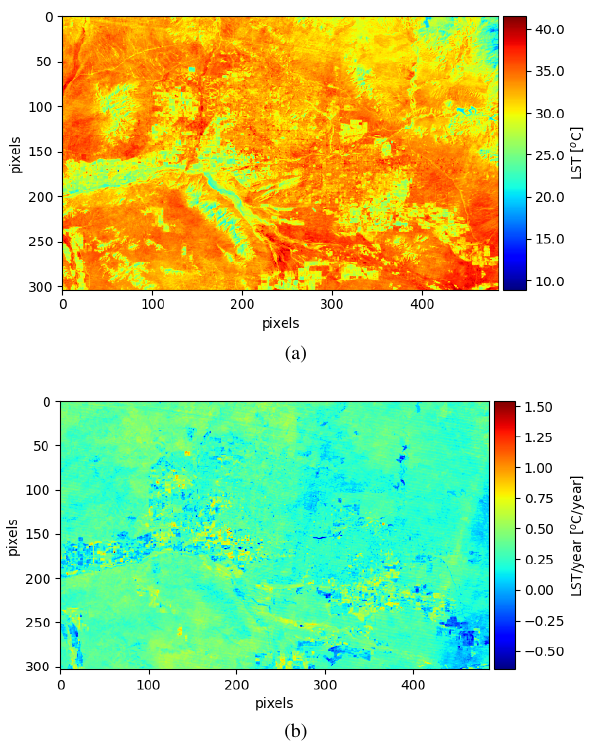
Figure 3: Map of the constant (a) and slope (b) parameters of the LST linear model Eq. 1 on the investigated